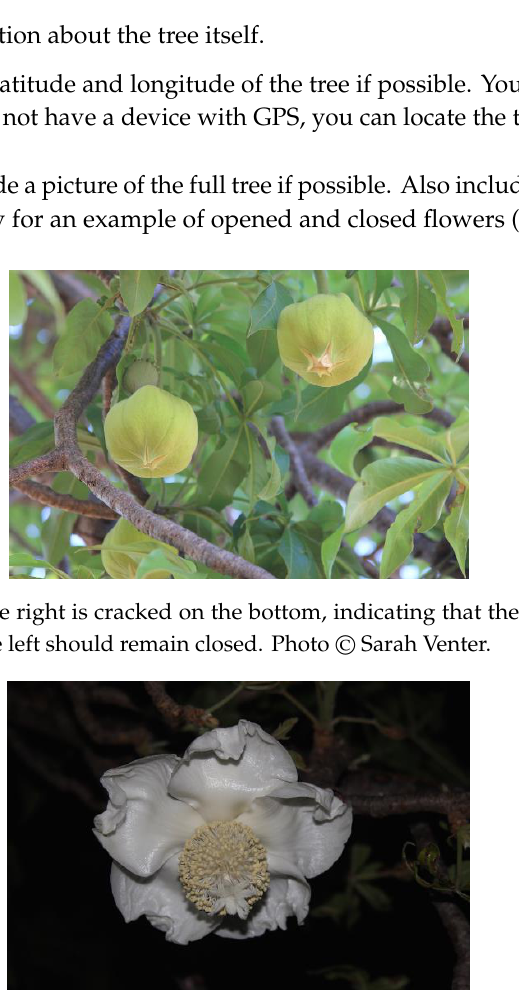
Figure A2. An open baobab flower. Photo © Sarah Figure C2. An open baobab flower.